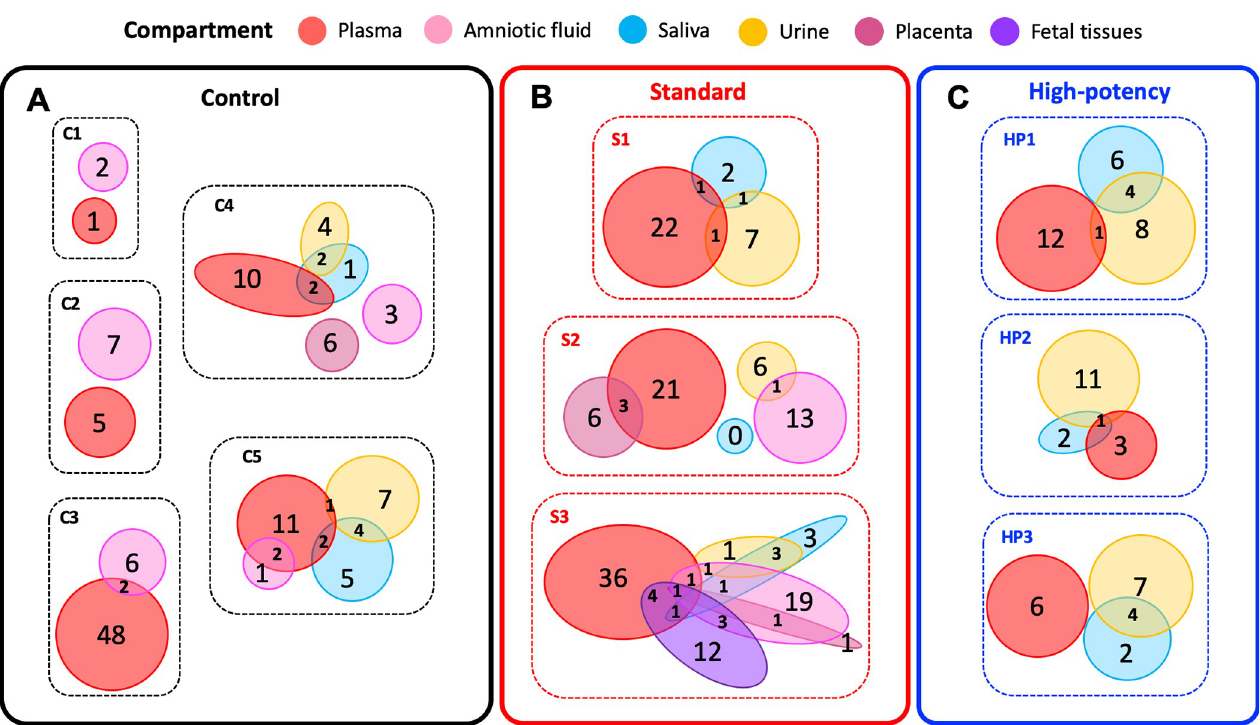
Fig 2. The number of minor UCD52 haplotypes at the gB locus that are either shared or unique across compartments, by monkey. Here, the set of minor haplotypes for a given compartment includes all timepoint samples from that compartment. Patterns of minor haplotype sharing for (A) control group monkeys, (B) standard pretreatment group monkeys, and (C) high-potency pretreatment group monkeys. Compartments are color-coded as in Fig